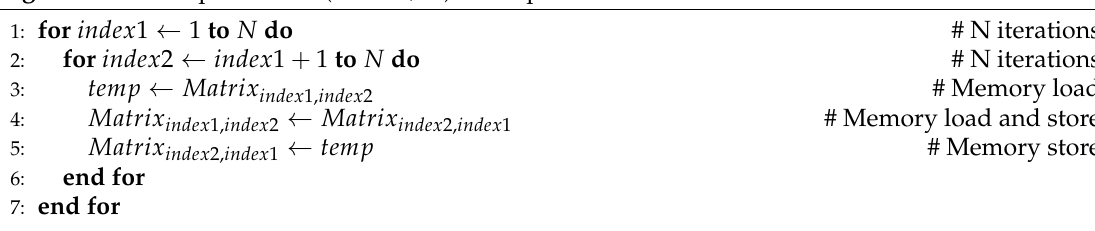
Algorithm 1 TransposeMatrix( Matrix , N ): Transposes a N